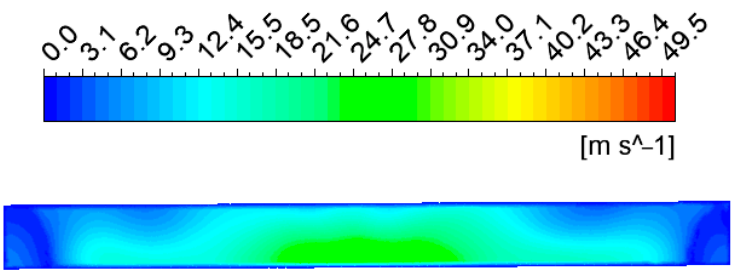
Figure 13. Velocity nephogram of film conveying port surface.